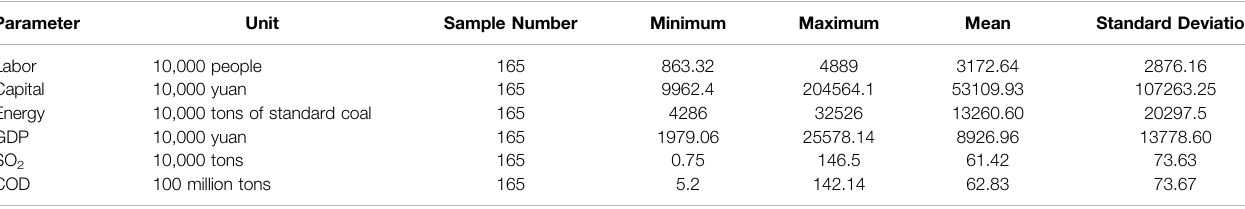
TABLE 1 | Statistics on intakes and outcomes.